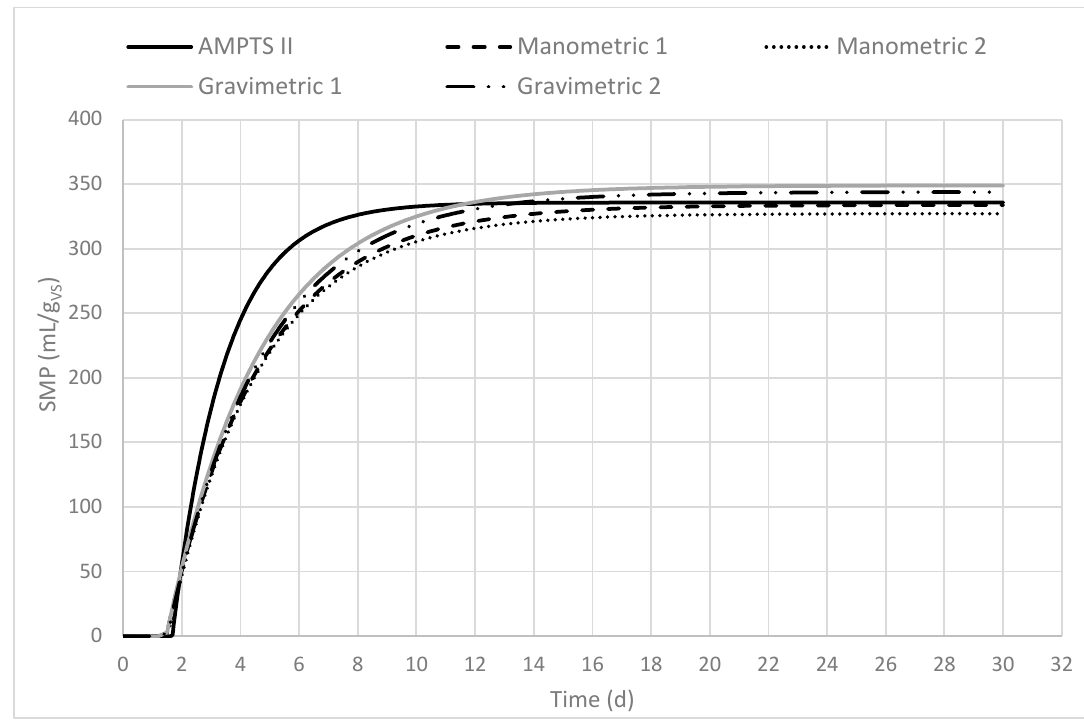
Figure 7. Specific methane production for each method along the test duration. Each line illustrates the first-order model of BMP calibrated for each method (values of Table 4).